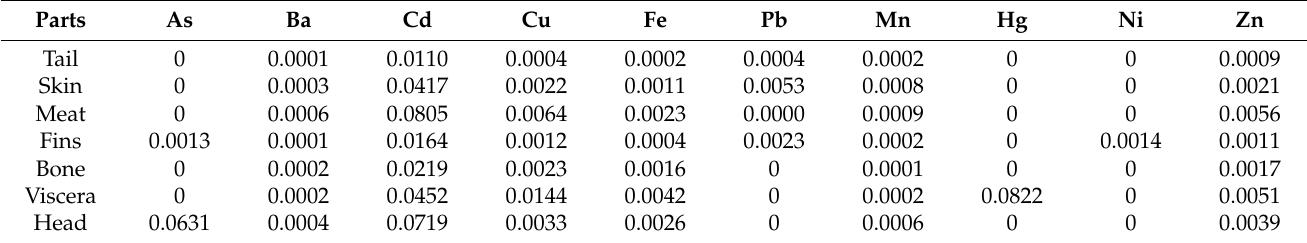
Table 6. THQ of HMs in each part of Tilapia